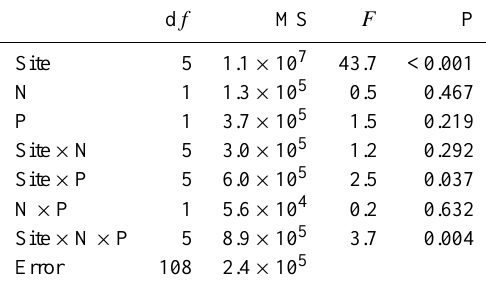
Table 3. Results of 3-way ANOVA of site, nitrogen (N), and phos- phorus (P) addition on total soil organic carbon content (gm − 2 )